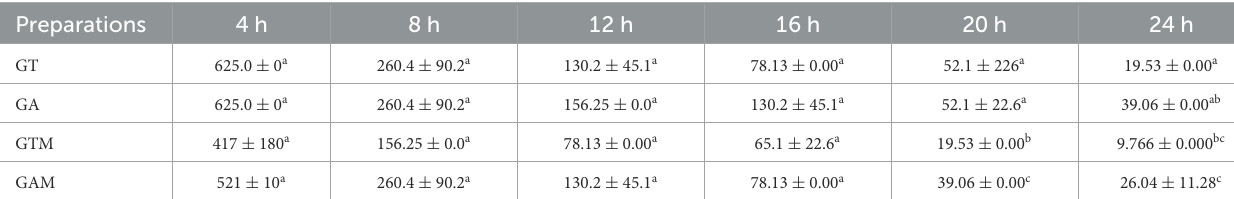
TABLE 4 Comparison of the minimum inhibitory concentrations ( µ g/mL) of different gel-based preparations against K. pneumoniae at each time